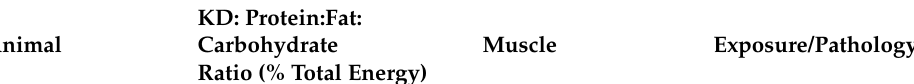
Exposure/Pathology Outcome Ref. KD abolished age-dependent muscle mass loss, and the mice treated with butyrate from Gastrocnemius– Age-related muscle plantaris with atrophy soleus